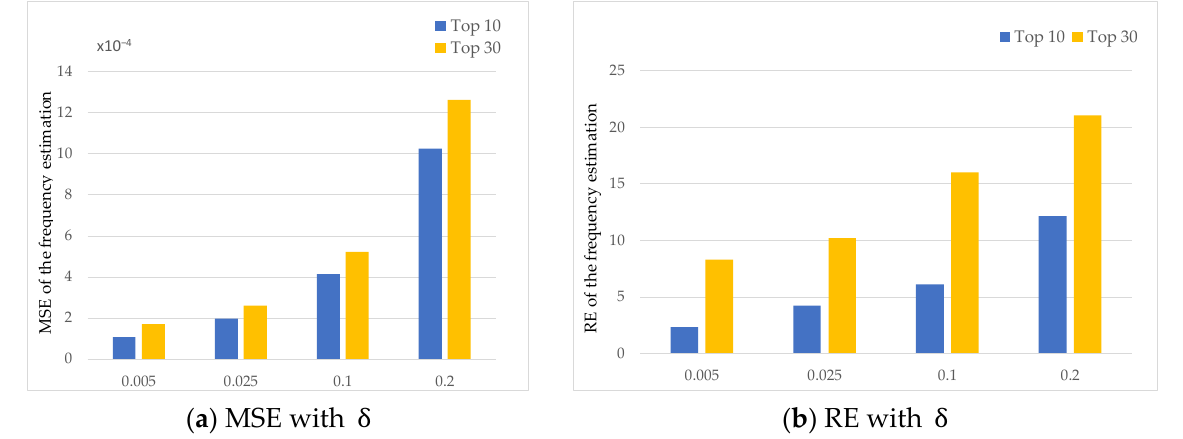
Figure 6. MSE and RE of the frequency estimation with different δ .